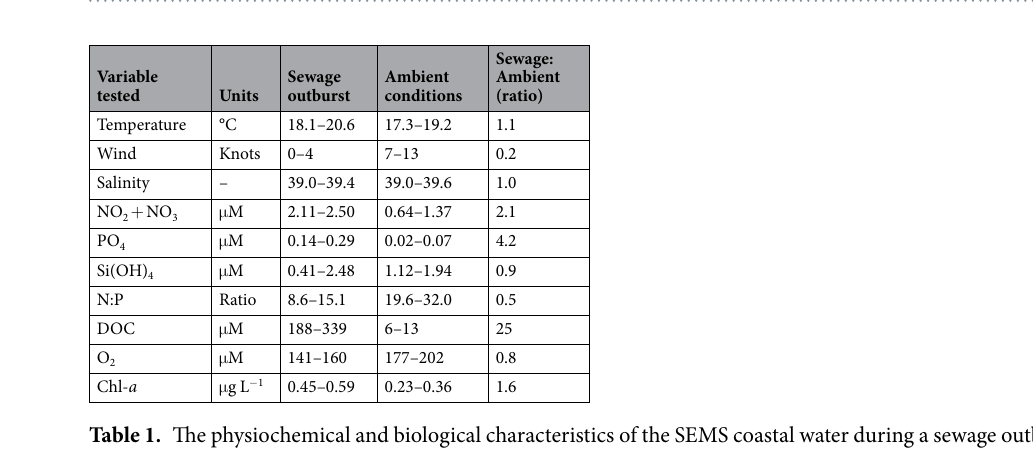
Figure 2. The temporal distribution of ( A ) microphytoplankton ( B ) autotrophic and heterotrophic bacteria, ( C ) the relative abundance of T. erythraeum (from all nifH OTUs) and corresponding microscopical counts, ( D ) bacterial and primary production (BP and PP, respectively) and N 2 fixation rates. Measurements were taken prior to, during, and after a sewage outburst event at the coastal SEMS during wintertime (January to March 2015). Values presented are averages and their corresponding standard deviations (n = 3–5).